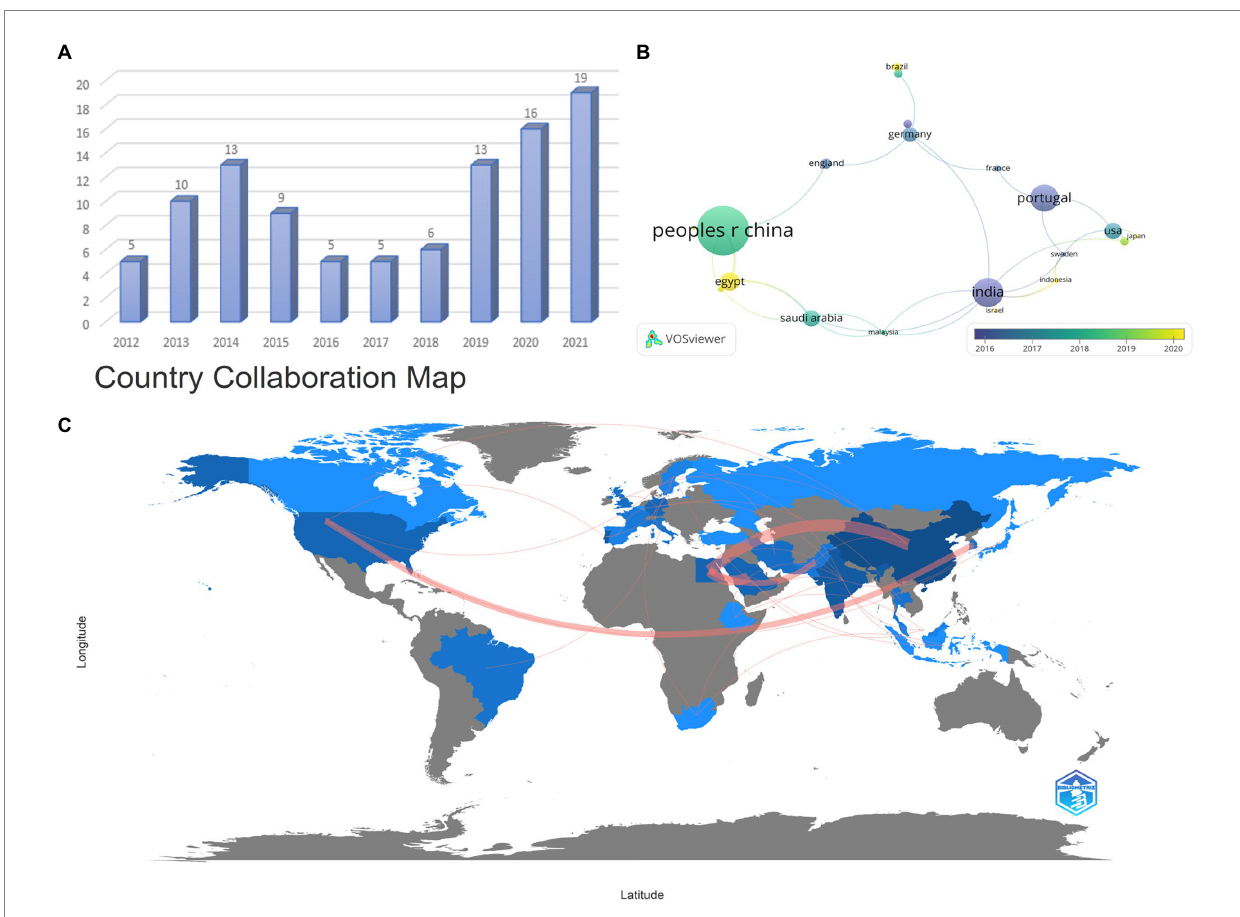
FIGURE 2 Annual publication status (A) , major productive countries distribution (B) , and Country Collaboration Map (C) . Each node represents a country, and the line between the two nodes indicates that they have a co-occurrence relationship. The larger the node means the greater the volume of national publications. The closer the distance, the stronger the relationship. Moreover, the more yellow the color tends to be, the more cutting-edge the research is (A,B) . The red path signifies the partnership between the countries, and the wider the red means the closer the cooperation (C)